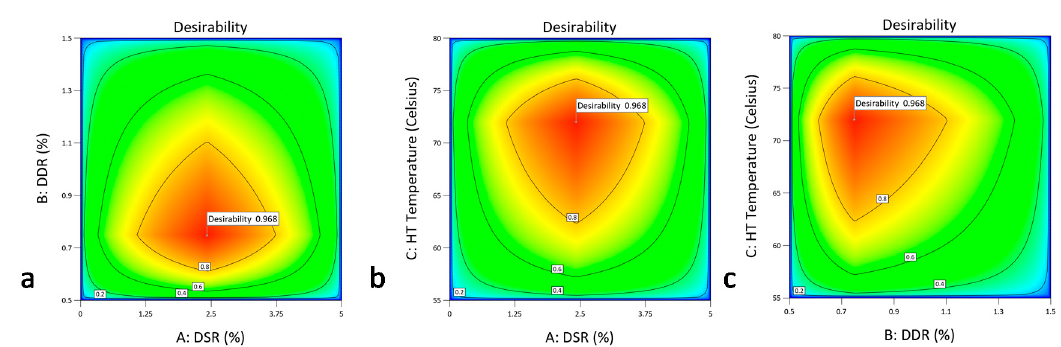
Figure 9. Contour plots of desirability function used to explore the overall factor interaction space for the combinatory fullfilment of all the CQA criteria: ( a ) drug-stabilizer ratio and drug-mannitol ratio, ( b ) inlet temperature and drug-stabilizer ratio, and ( c ) inlet temperature and drug-mannitol ratio.